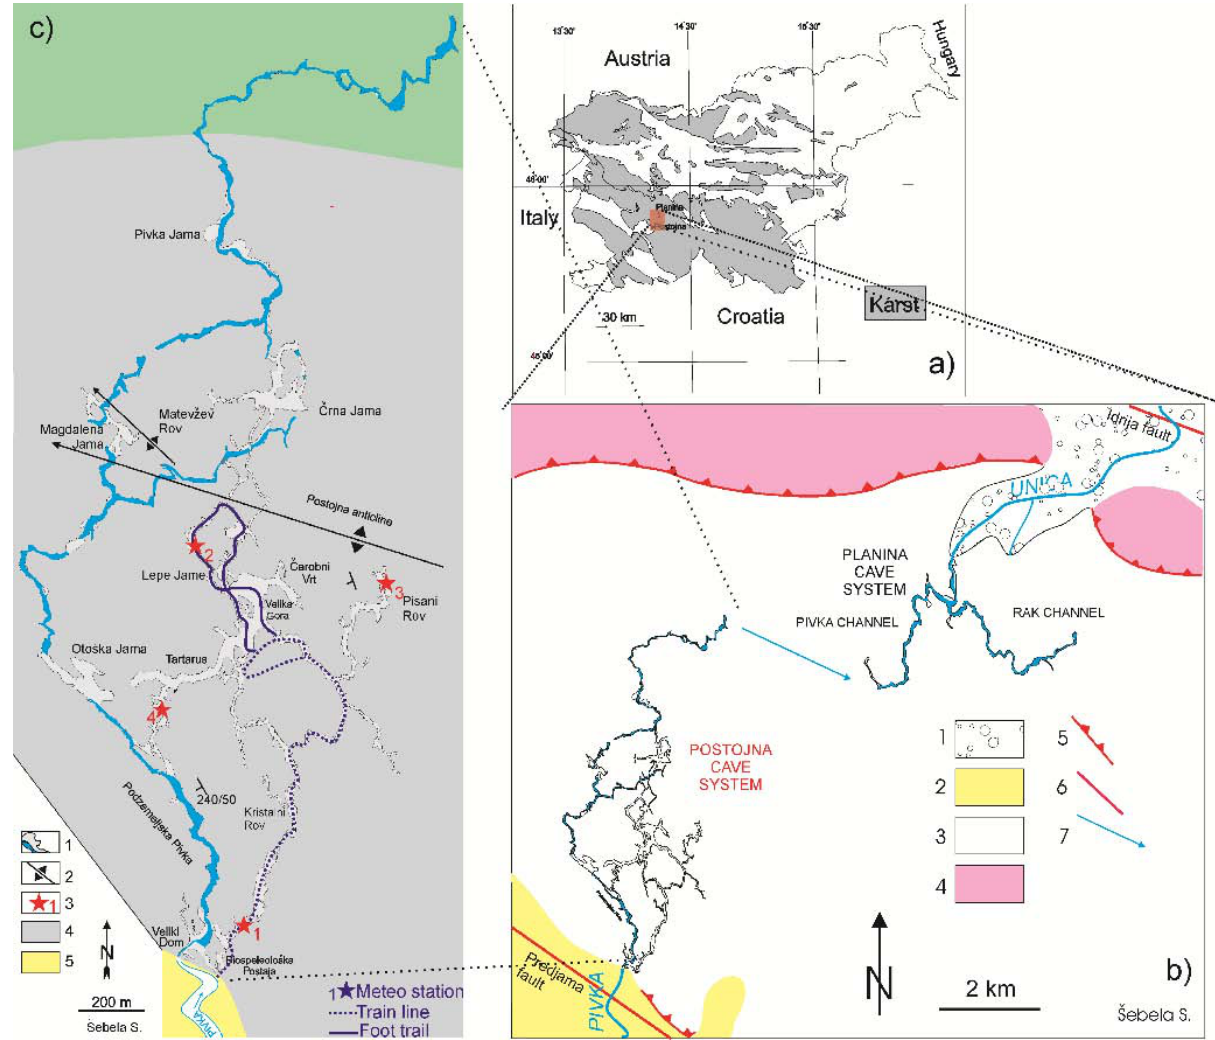
Fig. 1. Geological and speleological overview of Postojnska jama (Postojna Cave system). (a) Map of Slovenia with shaded karst regions and area of Postojna and Planina Cave systems. (b) Postojna and Planina cave systems. Legend: (1) Planina polje, (2) Pivka flysch basin, (3) limestone area, (4) dolomite rock, (5) thrust line, (6) fault line, and (7) water direction. (c) Postojna Cave system with position of micrometeorological stations, train line and foot trails. Other symbols: (1) cave channels with active flow marked in blue, (2) anticline, (3) meteorological stations, (4) limestone area, and (5) flysch area. Cartography by Stanka